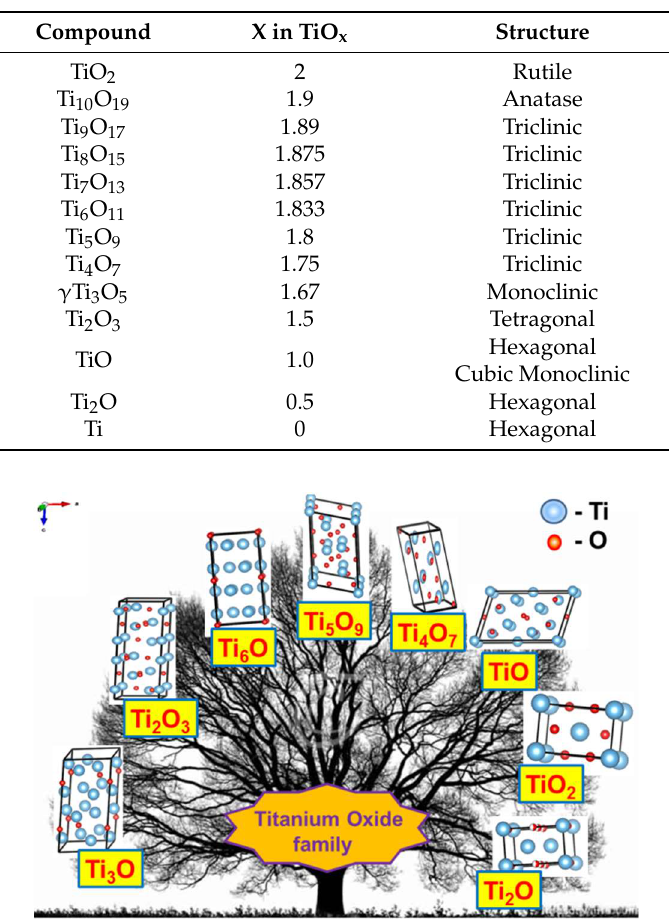
Figure 6. Crystal structures of various titanium oxides.